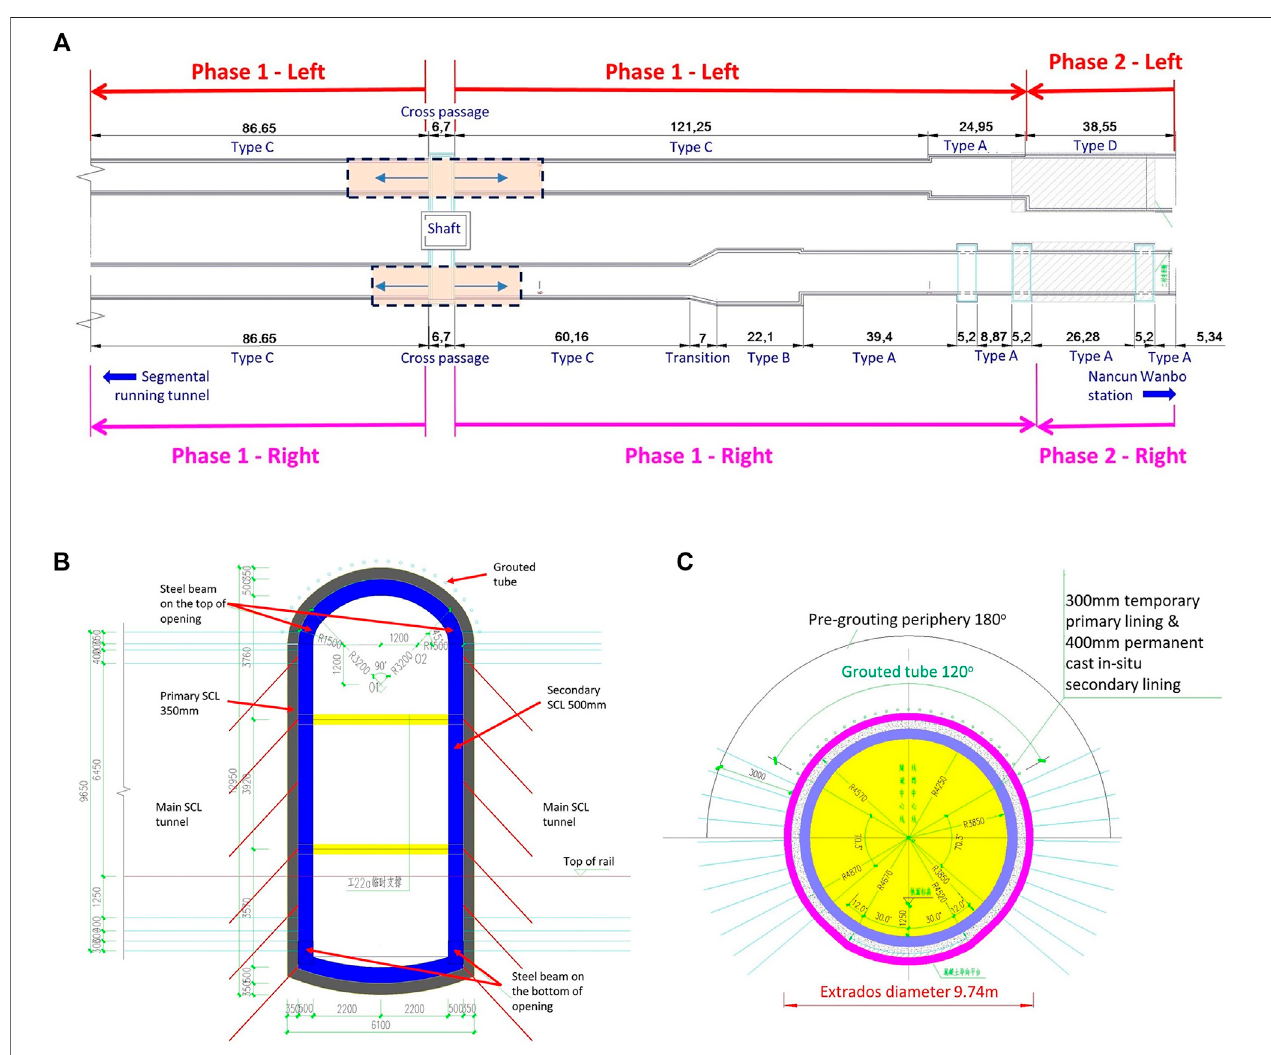
FIGURE 4 | SCL tunnel construction arrangement: (A) overall plan; (B) cross section of cross passages; (C) cross section of SCL tunnel Type C.